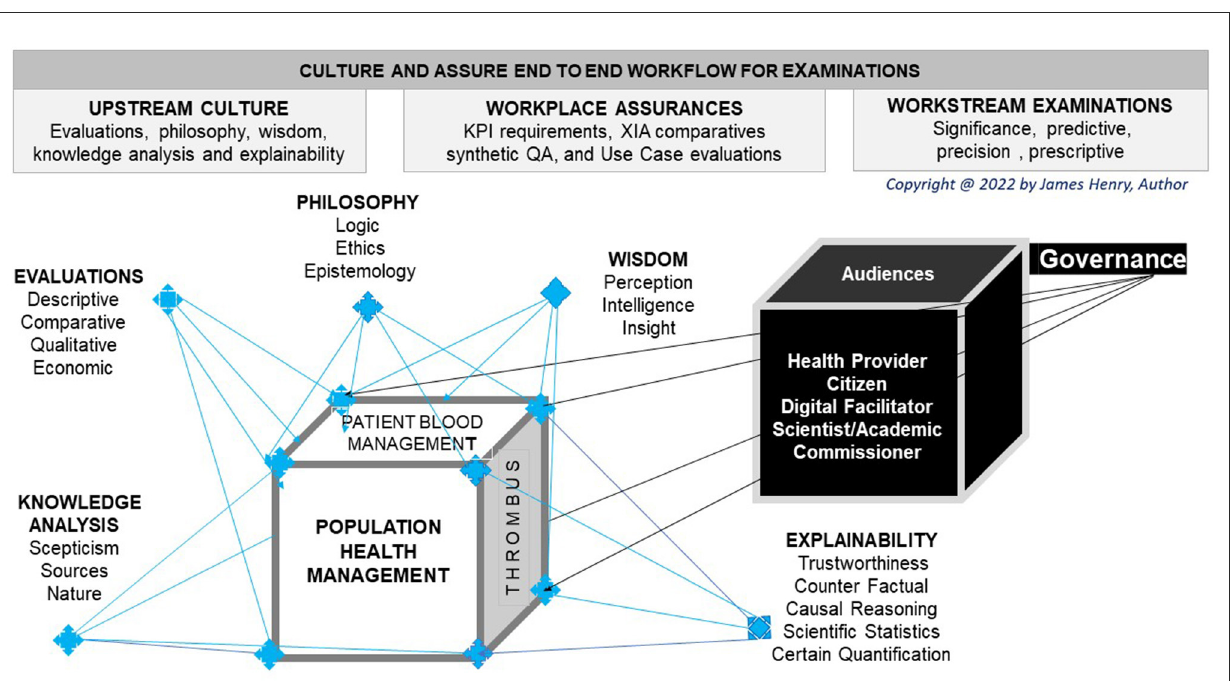
FIGURE3 Culture work, assure